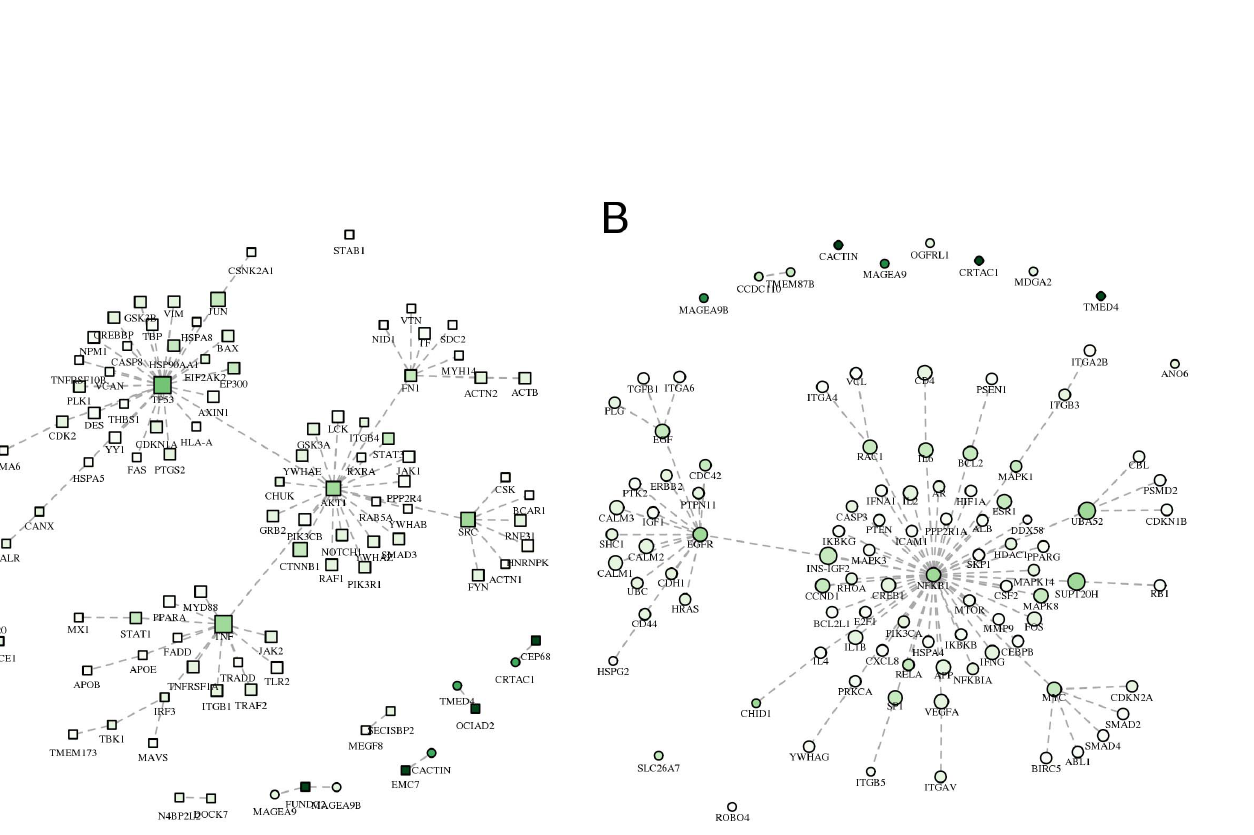
Figure 2. Most relevant relationships between proteins in network proximity to HCV proteins. MSTs among the ( A ) 100 proteins with the highest network proximity score ( s i ) and ( B ) 100 proteins with the highest s i excluding HCV targets, using edge weights ( w ij ) inversely proportional to the product of proteins network proximity scores: w ij 5 1 - s i s j . A–B ) The darker the color, the higher the network proximity score; squares: HCV targets; circles: non-HCV targets; vertex size is proportional to the number of interactions in the host interactome.